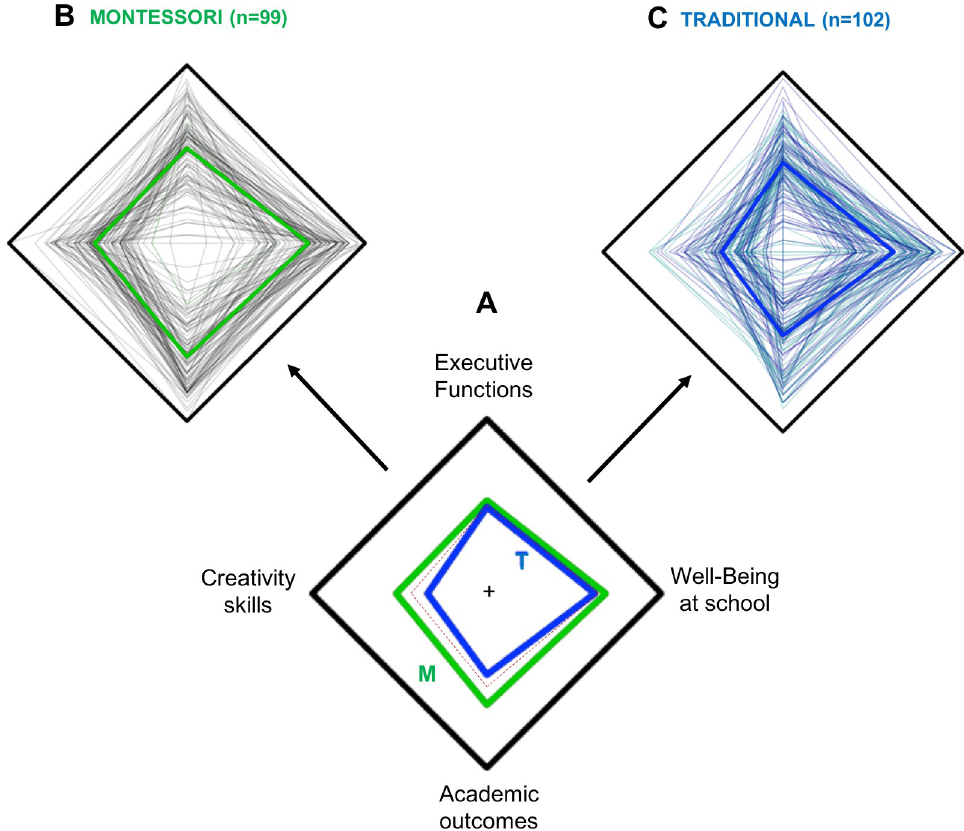
Fig 2. Radial qualitative representation of the four different cognitive measures: executive functions, creativity skills, well-being at school, and academic outcomes, each located at a summit. The scales depend on the measured cognitive skill; however, all run from the minimum at the center to the maximum at the border of the square. Individual results are represented with a thin line (Montessori schoolchildren on top left 2B, and control on the top right 2C), and mean for each group is reported with a bold line in the central square 2A, where the dotted red line marks the 0 of each cognitive measure’s z-score scale. Montessori (M) depicted in green, traditional (T) in blue. Group differences (M vs. T) are observed for creativity skills and academic